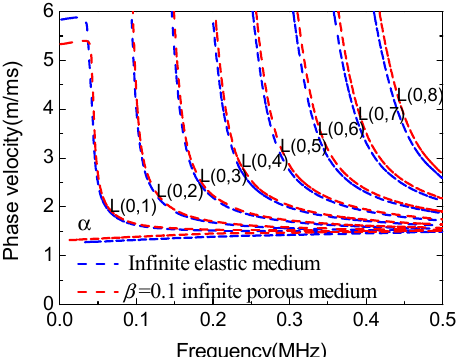
Figure 2. Dispersion curves of guided waves in water-filled pipe embedded in different media. The internal and external radii of the pipe are a = 14 mm and b = 16 mm, respectively. The vertical and horizontal axes depict the phase velocity and frequency. Blue and red lines represent propagating modes in the water-filled pipe embedded in infinite elastic and porous media, respectively.